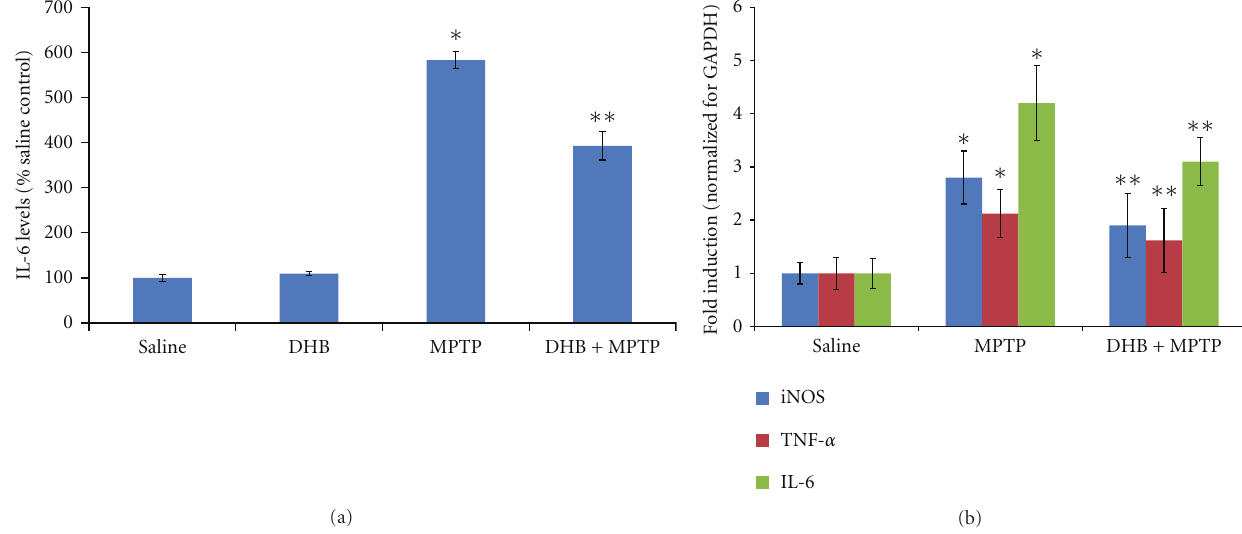
Figure 7: Mice were pretreated with DHB (100mg/kg, intraperitoneally) 6h prior to administration of either saline (Sal) or MPTP (20mg/kg x2, 12 h apart). Animals were sacrificed 2 days later. (a) Levels of striatal IL-6 were measured using an ELISA kit from BD Biosciences. Each bar represents mean + SEM for 4 animals in each group. ∗ P < 0 . 05 compared with the Sal group, ∗∗ P < 0 . 01 compared with the MPTP- treated group. (b) DHB pretreatment decreases the mRNA levels of MPTP upregulated proinflammatory cytokines. ∗ P < 0 . 05 compared with the Sal group, ∗∗ P < 0 . 05 compared with the MPTP-treated